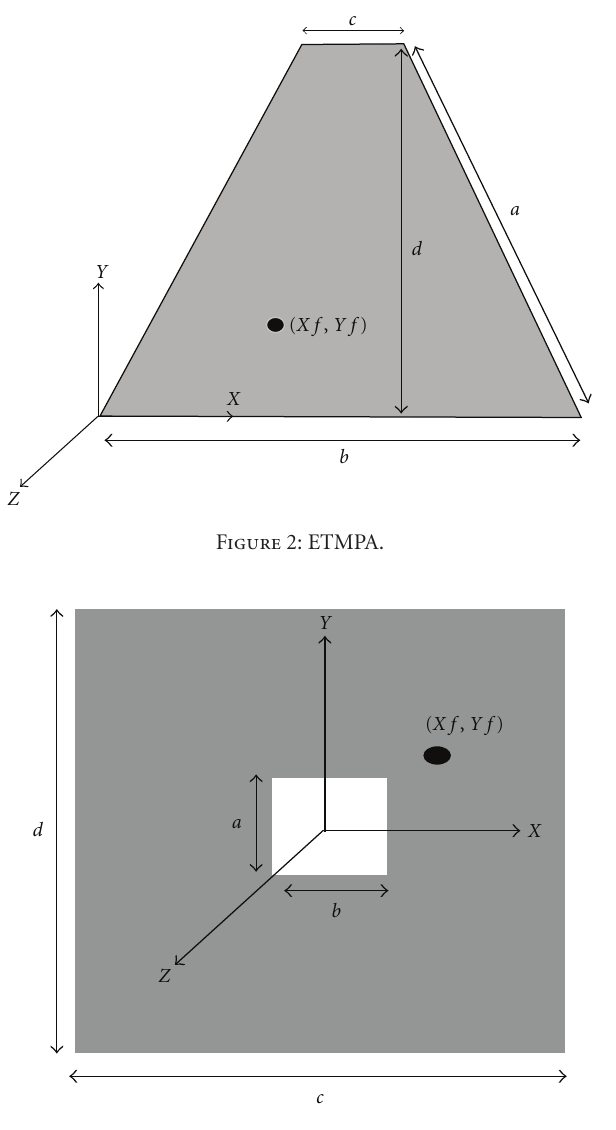
Figure 3: Square ring patch antenna.